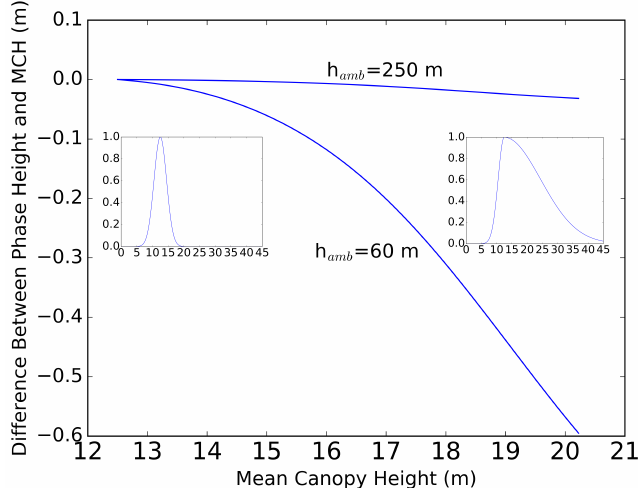
Figure 4. The calculated difference between phase-height and mean canopy height (power-profile-averaged height), realized for an asymmetric-Gaussian hypothetical model of the volume radar power profile p ( z (cid:48) ) as in (7). σ left is held at 2 m. When σ left = σ right , p ( z (cid:48) ) is symmetric, the h φ -MCH difference is zero, and MCH = 12.5 = z 0 . The symmetric profile of p ( z (cid:48) ) versus altitude in meters is in the left-hand inset. With σ right = 12, the right-hand inset shows the highly asymmetric power profile as a function of altitude in meters, and the h φ -MCH difference is difference is plotted against MCH, which goes from 12.5 to 20 m when σ right is increased from 2 to 12 m. The difference is shown for two heights of